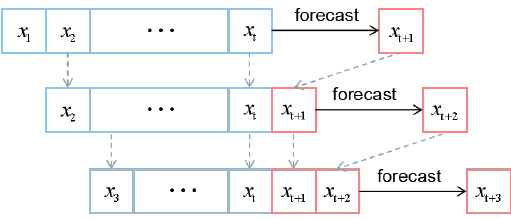
Figure 4. The process of the rolling forecast.